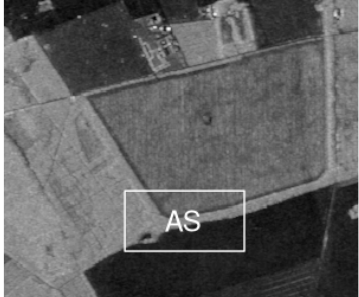
Figure 3. Selected area of EMISAR image Foullum (channel HH) to determine the average matrix as a real values form in the data